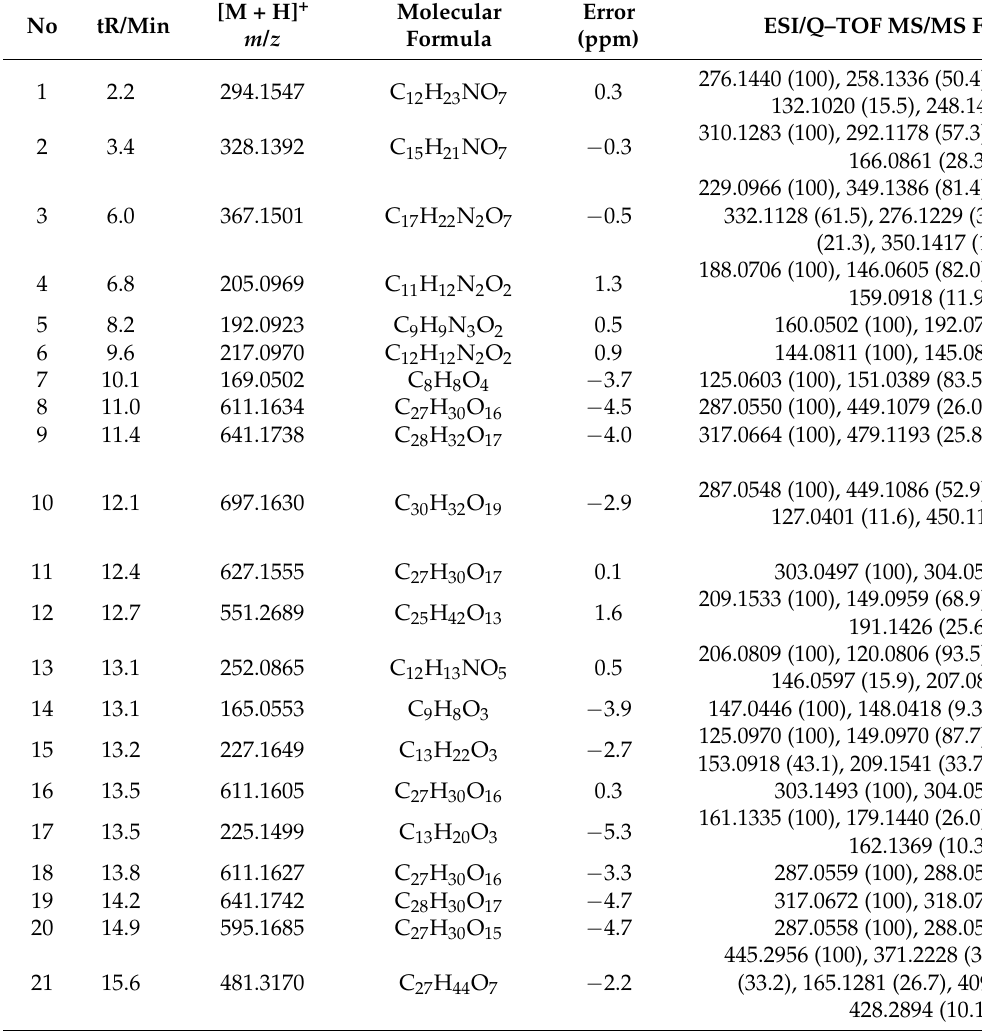
Table 1. Compounds identified in the extracts of different fractions from PPL by UPLC/Q − TOF